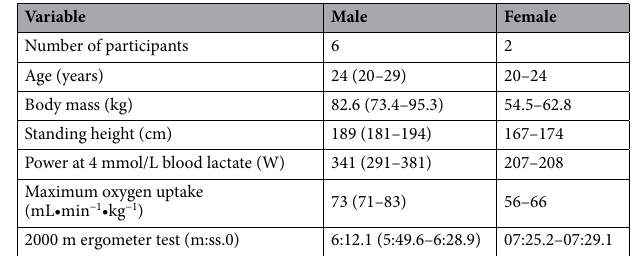
Table 1. Baseline characteristics of the eight rowers. Data are provided as median (minimum–maximum).